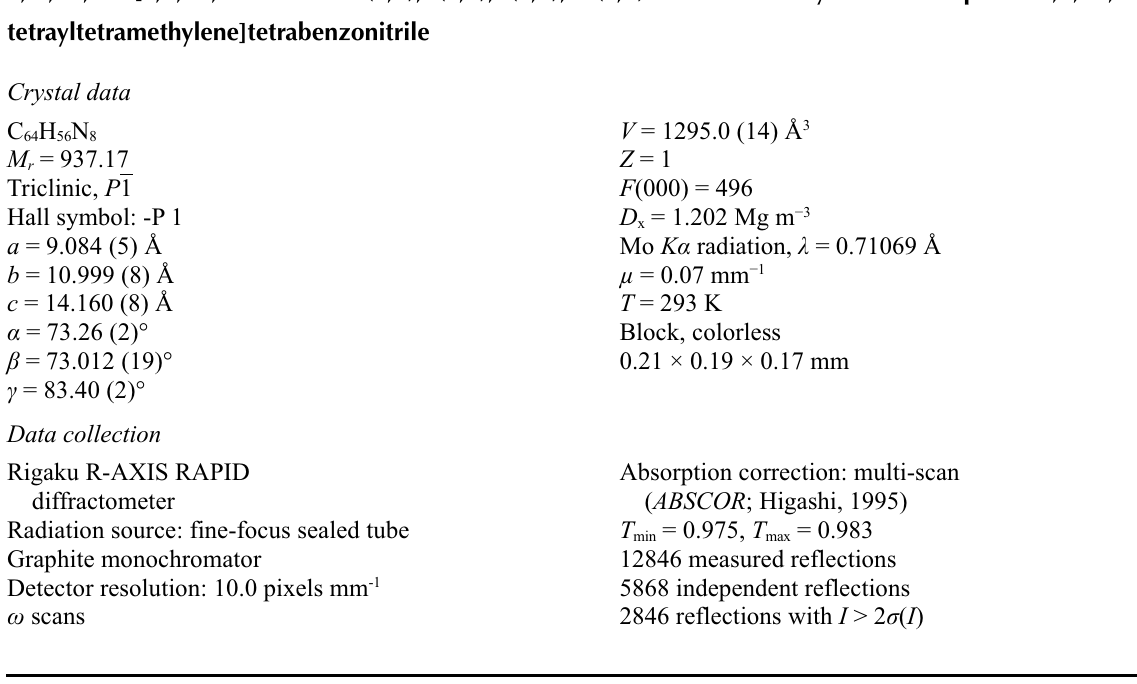
A view down the b-axis of the unit cell contents for